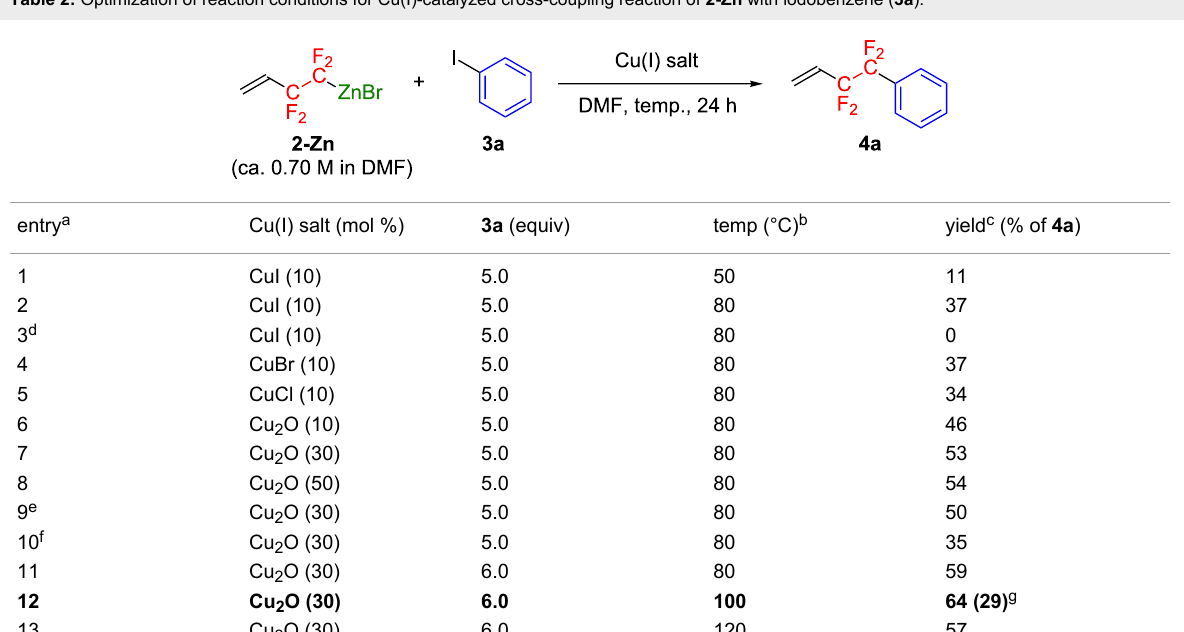
Table 2: Optimization of reaction conditions for Cu(I)-catalyzed cross-coupling reaction of 2-Zn with iodobenzene ( 3a ).